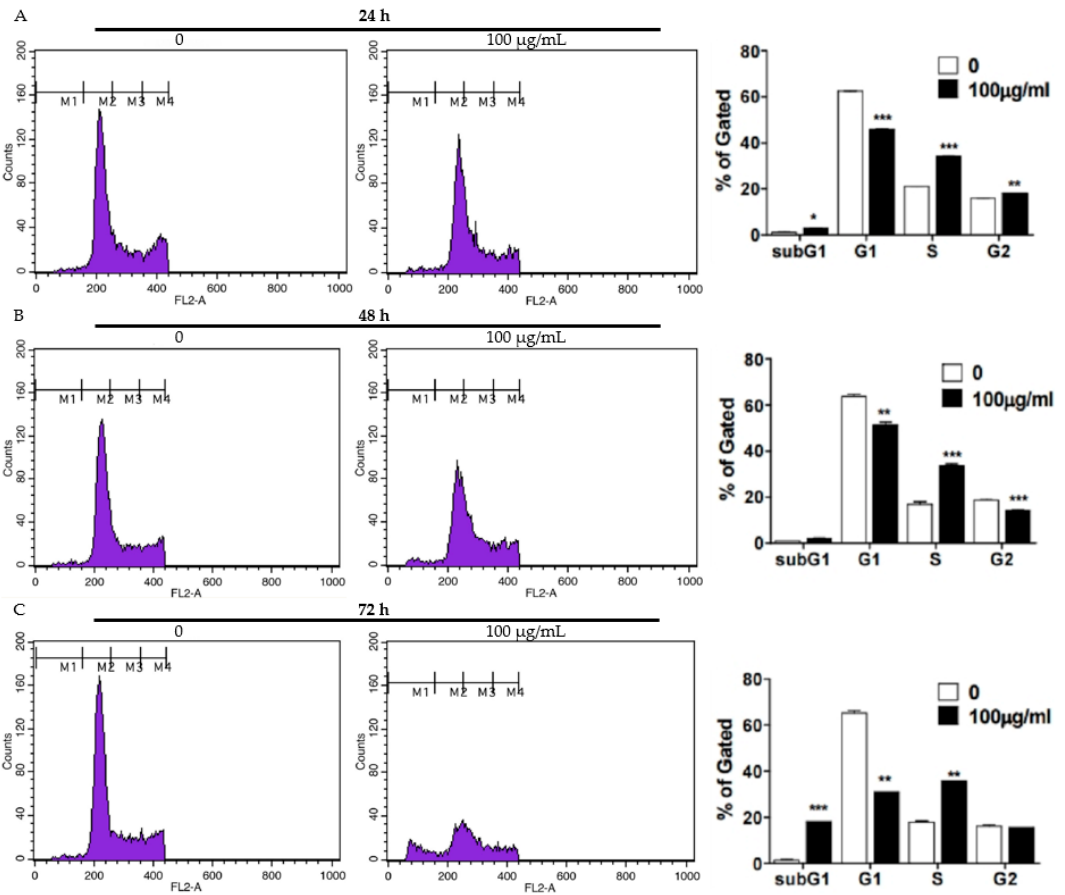
Figure 2. Effect of FFE on cell cycle arrest and apoptosis in MDA-MB-231 cells. MDA-MB-231 cells treated with FFE for 24 h ( A ), 48 h ( B ), and 72 h ( C ). Treated cells stained with propidium iodide (PI) and analyzed by flow cytometry. Bar graphs show quantification of the cell cycle population (%).